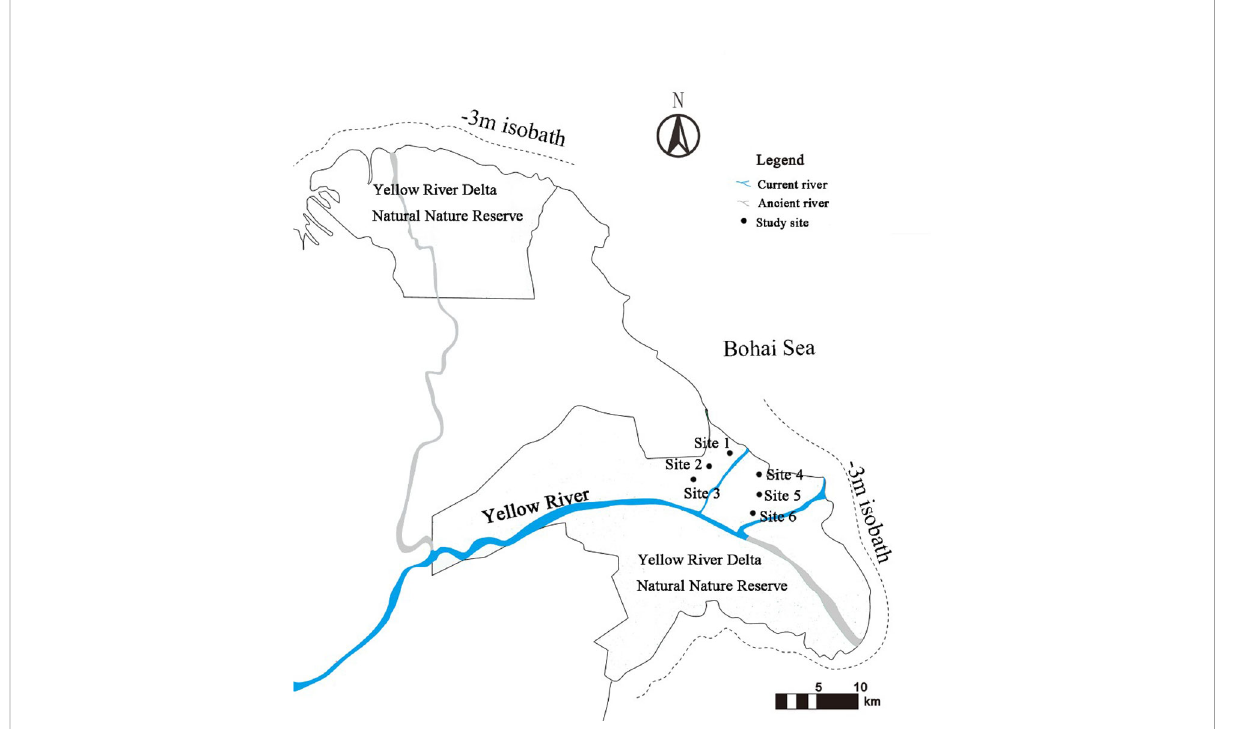
FIGURE 1 Map of the six study sites in the Yellow River